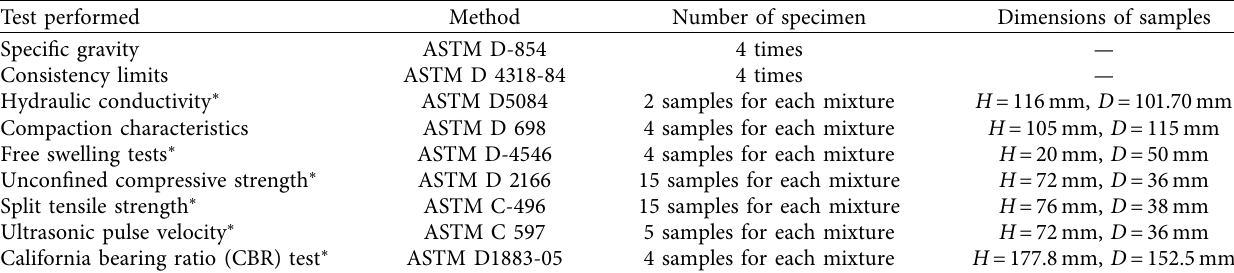
Table 2: Experimental test program.